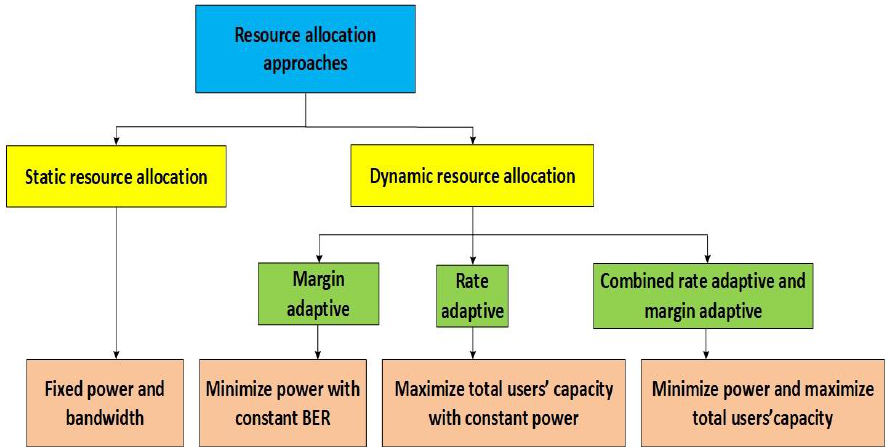
Figure 2. Different approaches to dynamic resource allocation in OFDM systems.